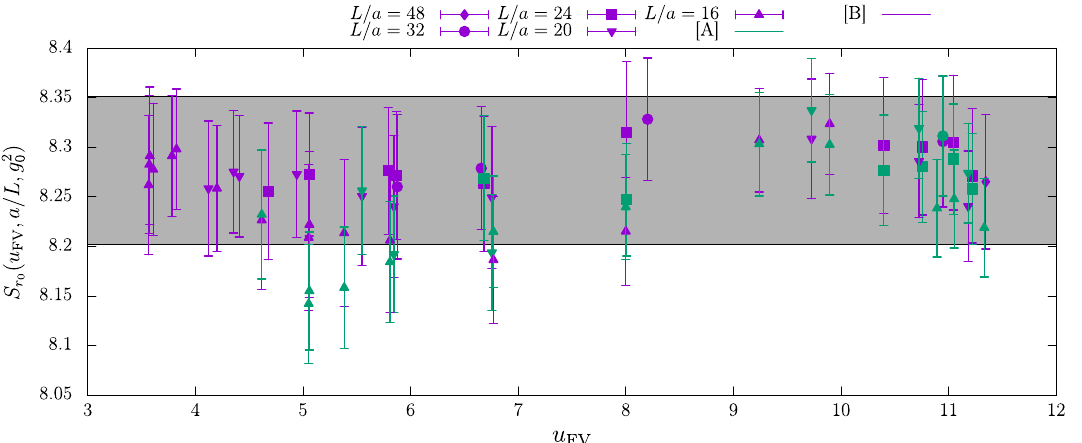
( u , a / L , g 2 ) of the running factor R and Fig. 10 The product S r FV 0 0 the matching factor Q r (analogous to Eq. (4.12) for r 0 ). This has to be 0 constant and equal to r 0 μ ref up to discretization errors; the plot clearly shows that these are very small for both data sets. In different colours